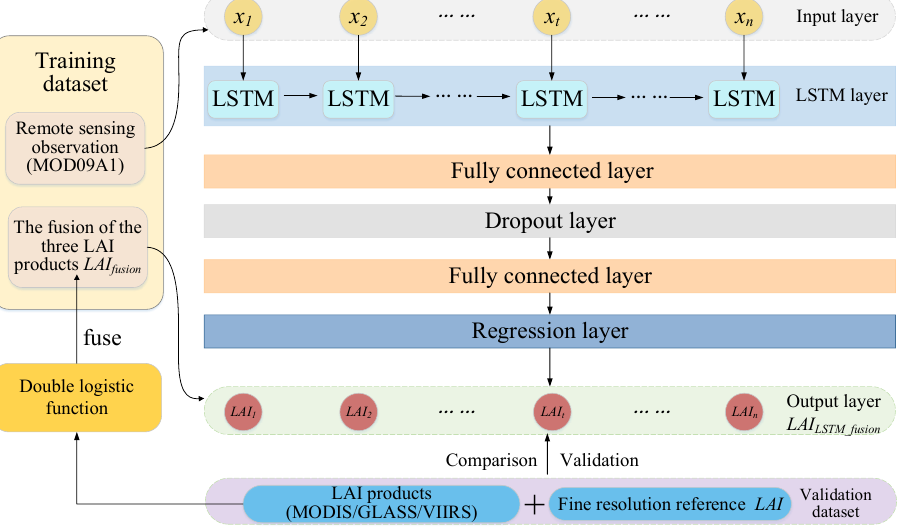
Figure 2. Flowchart of time-series LAI estimations through the integration of deep learning and multiple products.